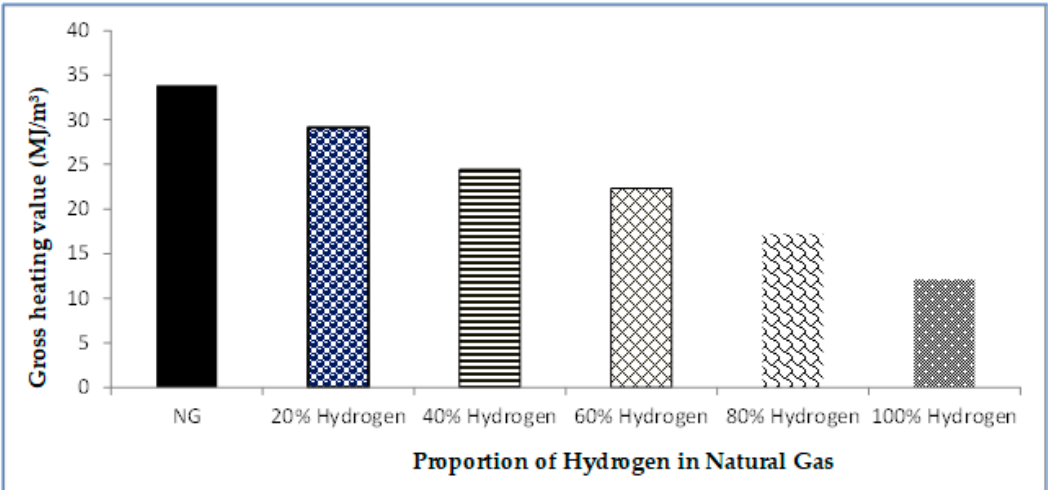
Figure 1. Energy contents of natural gas (NG) and hydrogen (H 2 ) blends.